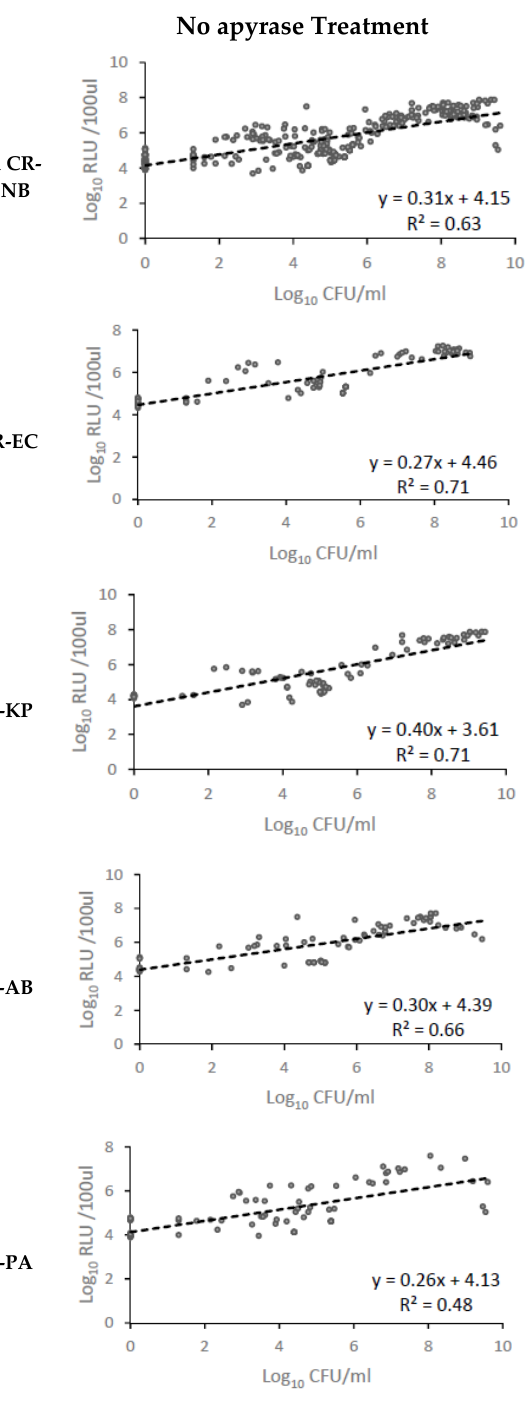
Figure 4. Correlation between viable counts (log 10 CFU/mL) and ATP bioluminescence (log 10 RLU/100 uL) in samples with and without apyrase (2 U/mL) in 24 h time–kill studies. Table 2. Comparison of coefficient of determination between viable counts (log 10 CFU/mL) and ATP bioluminescence (log 10 RLU/100 uL) with and without apyrase (2 U/mL) in 24 h time-kill studies.